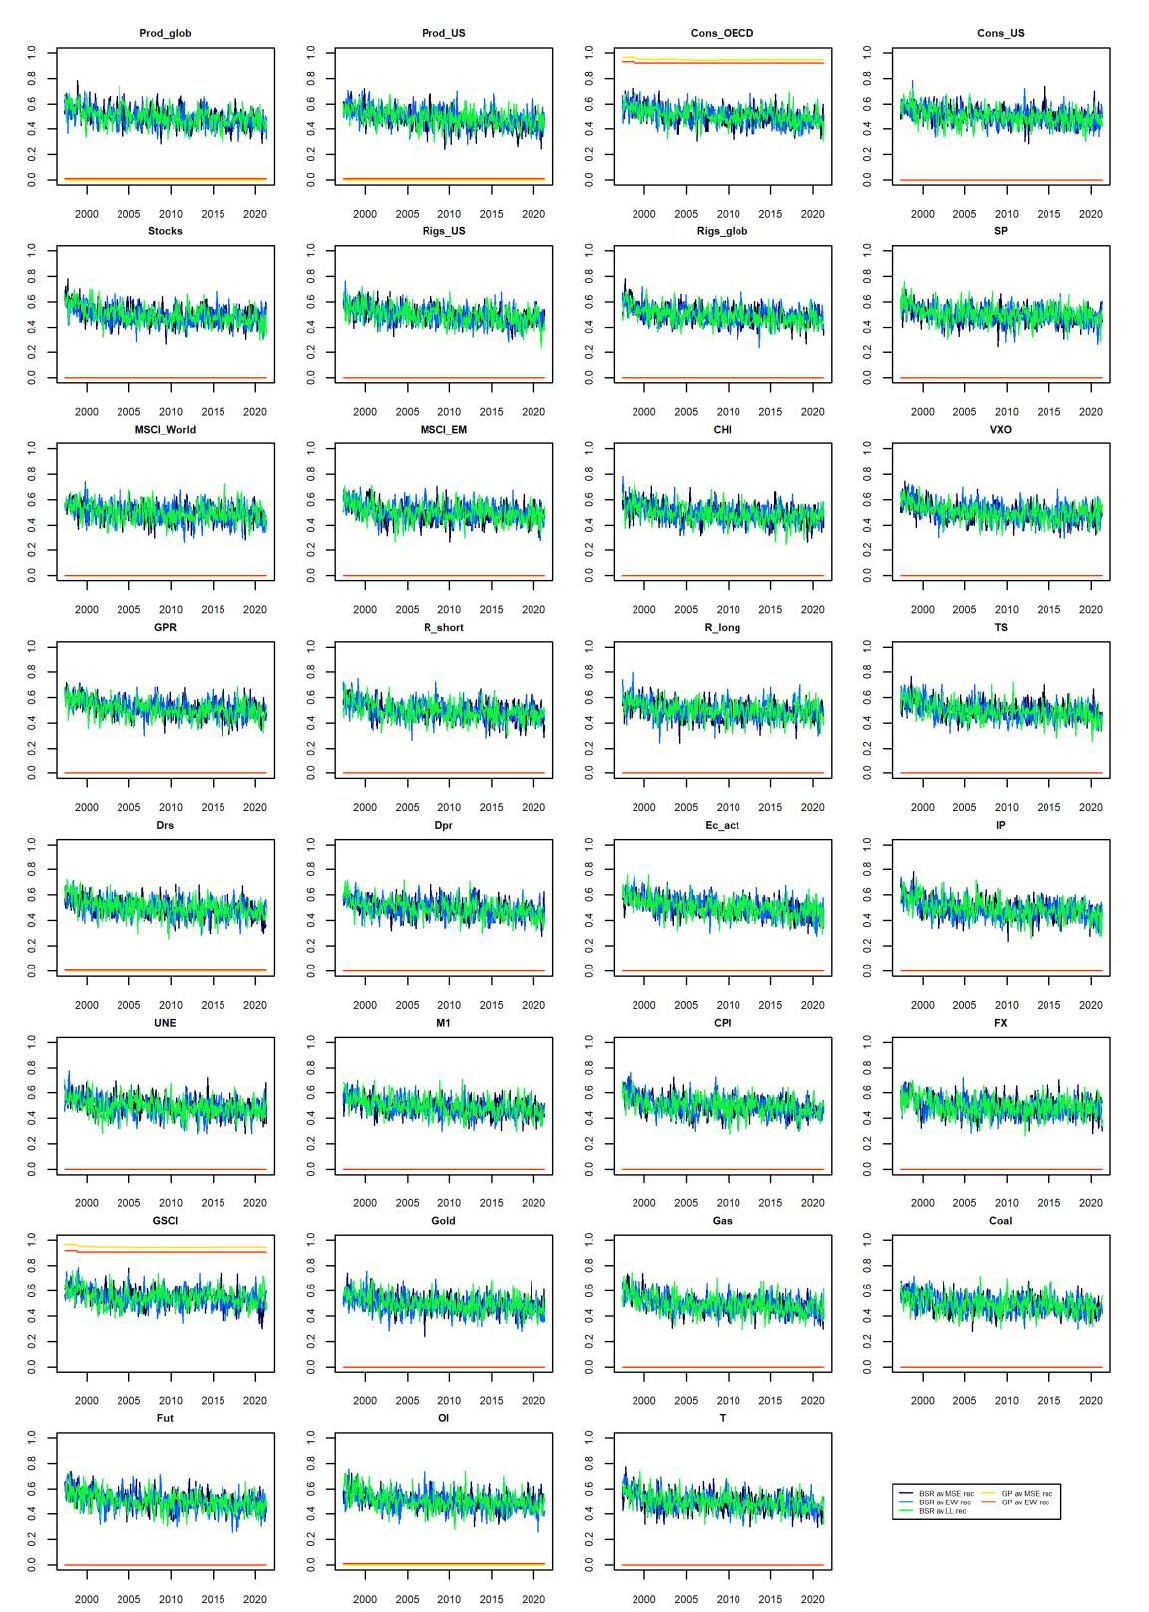
Figure 3. RVIs from suitable model combination schemes.